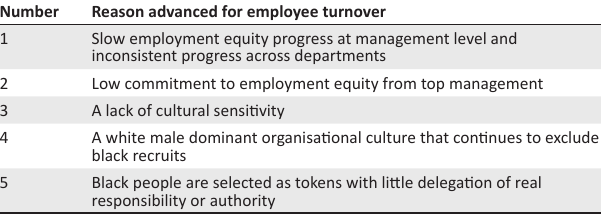
TABLE 1: Reasons for turnover amongst black